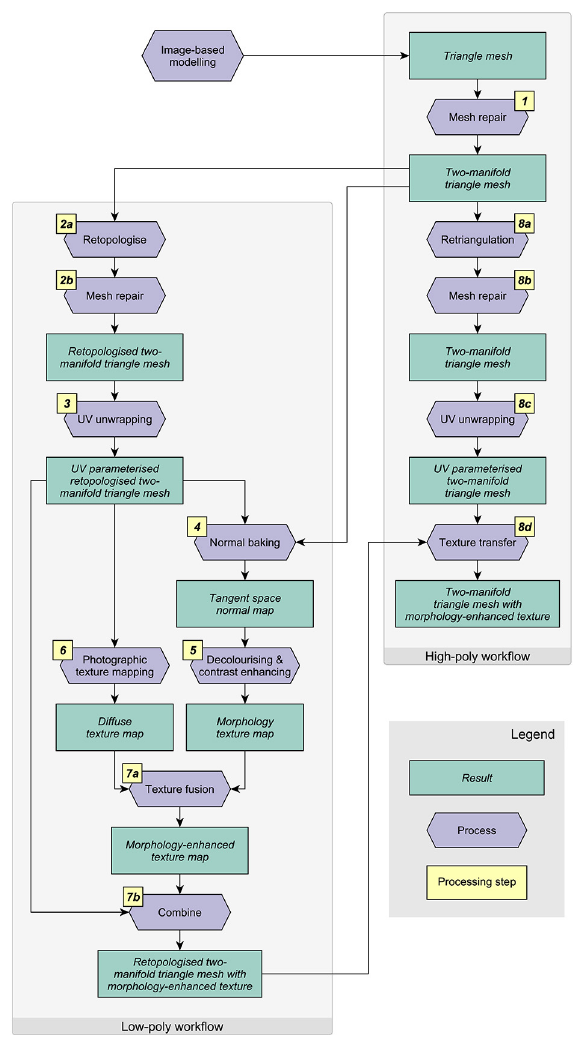
Figure 2. The complete processing workflow detailed in this paper. In the text, one finds more information about every